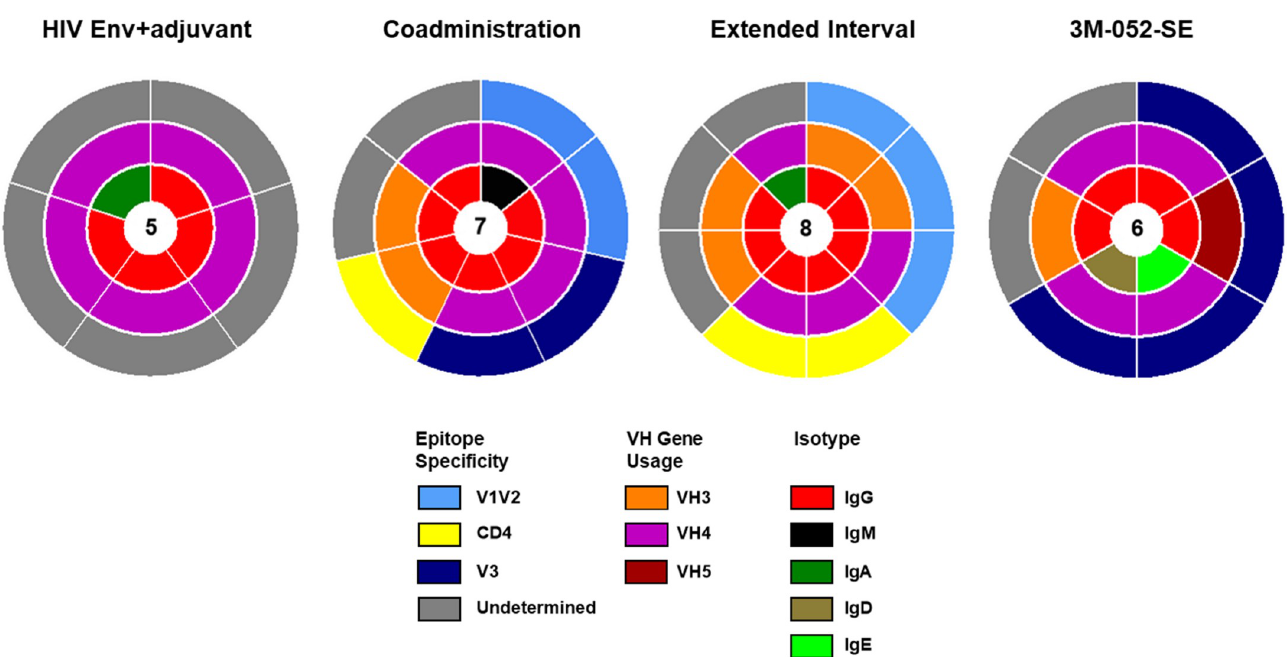
Fig 3. Analyses of epitope specificity and immunogenetic characteristics of the Env-specific functional heavy- and light-chains of 26 vaccine-elicited mAbs in infants using rhesus Ig-gene database. Reanalysis using newly developed software based on rhesus macaque Ig sequences confirmed that 26 of 39 heavy- and light- chain pairs previously identified using human Ig sequences were functional. Overall, the epitope specificities, VH gene family usage, and isotype distribution were similar across different vaccina groups. Epitope specificity, VH gene family usage, and isotype distribution of identified functional heavy and light chains are displayed in concentric circles. The number of mAbs per group is displayed in the